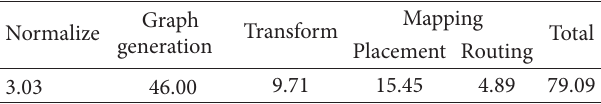
T 5: Average execution times in milliseconds of the